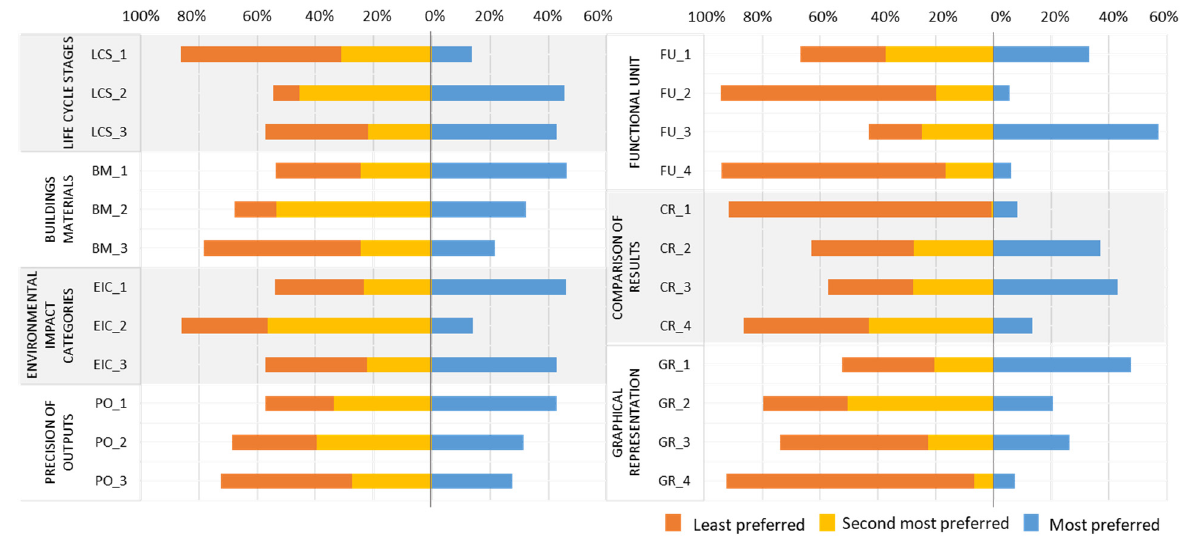
Figure 4. Ratings for the output’s preferences for decision-making. Life cycle stages: LCS_1 (Em- bodied vs. Operational); LCS_2 (Grouped life cycle stages); LCS_3 (All life cycle stages). Building